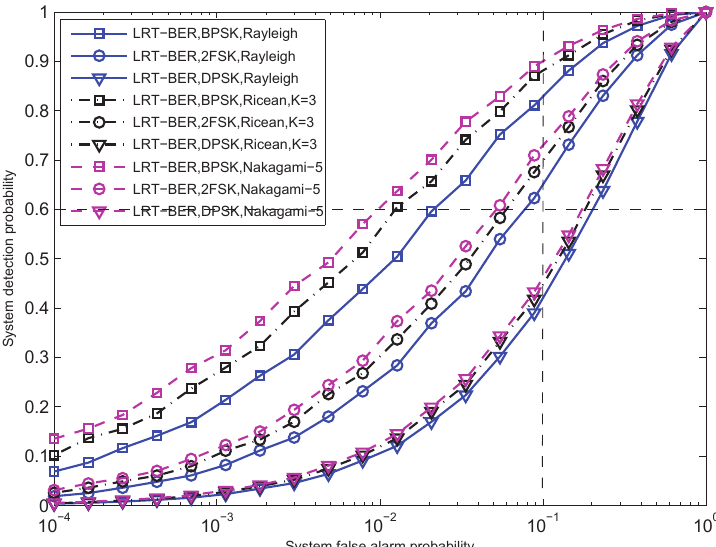
Figure 5. ROC curves for the LRT-BER fusion rule based on CF closed-form performance evaluation with N = 20. The average received SNR is ¯ γ index is assumed to be equal to each other ( P is P = FA